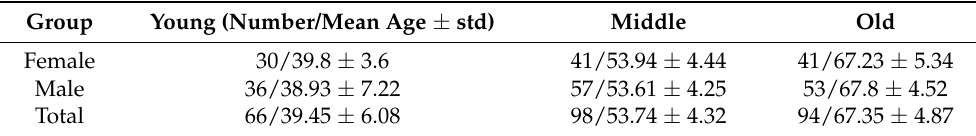
Table 1. Demographic data across different stages of adulthood in men and women. Group Young (Number/Mean Age ± std) Middle Old Female 30/39.8 ± 3.6 41/53.94 ± 4.44 41/67.23 ± 5.34 Male 36/38.93 ± 7.22 57/53.61 ± 4.25 53/67.8 ± 4.52 Total 66/39.45 ± 6.08 98/53.74 ± 4.32 94/67.35 ±